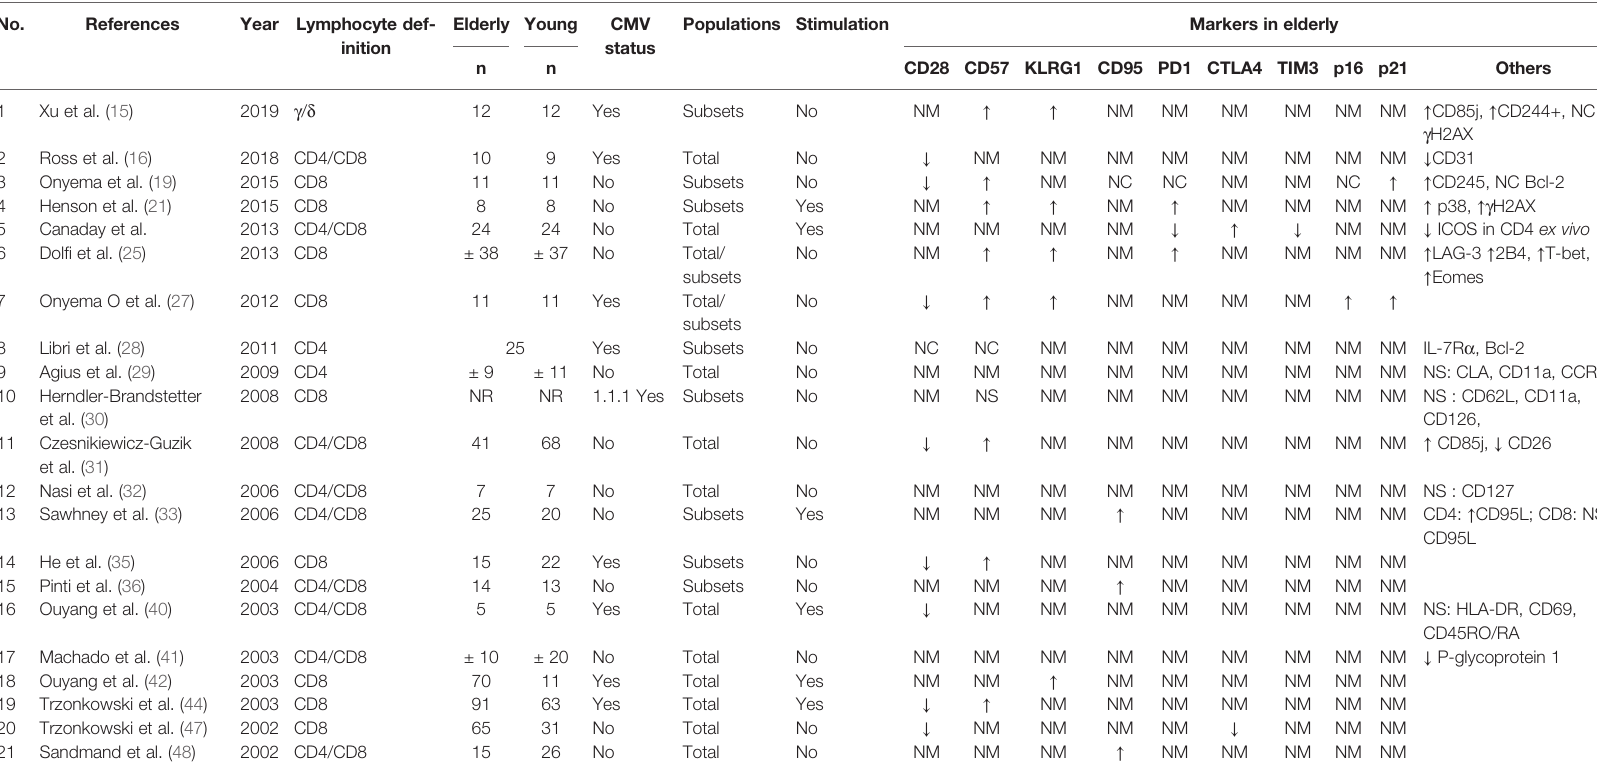
TABLE 2 | Characteristics of studies reporting immunosenescence